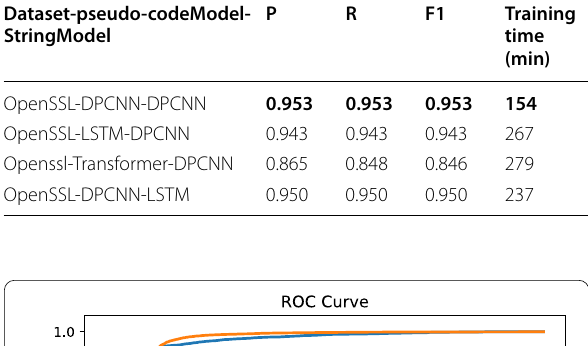
Fig. 7 ROC curves for UPPC, Gemini on the test set